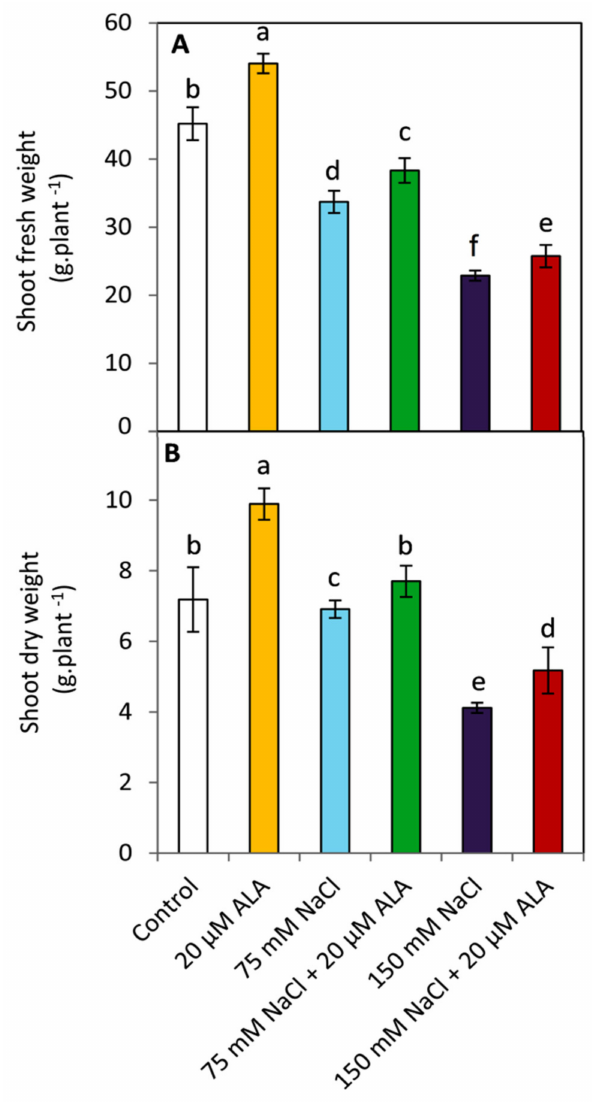
Figure 1. Effect of salinity stress as NaCl (0, 75 and 150 mM) and the foliar application by α -lipoic acid (ALA; 0 and 20 µ M) on ( A ) shoot fresh and ( B ) dry weight of sorghum plants. For each parameter, the mean values ± SD followed by a different letter are significantly ( p ≤ 0.05) different according to Tukey’s range